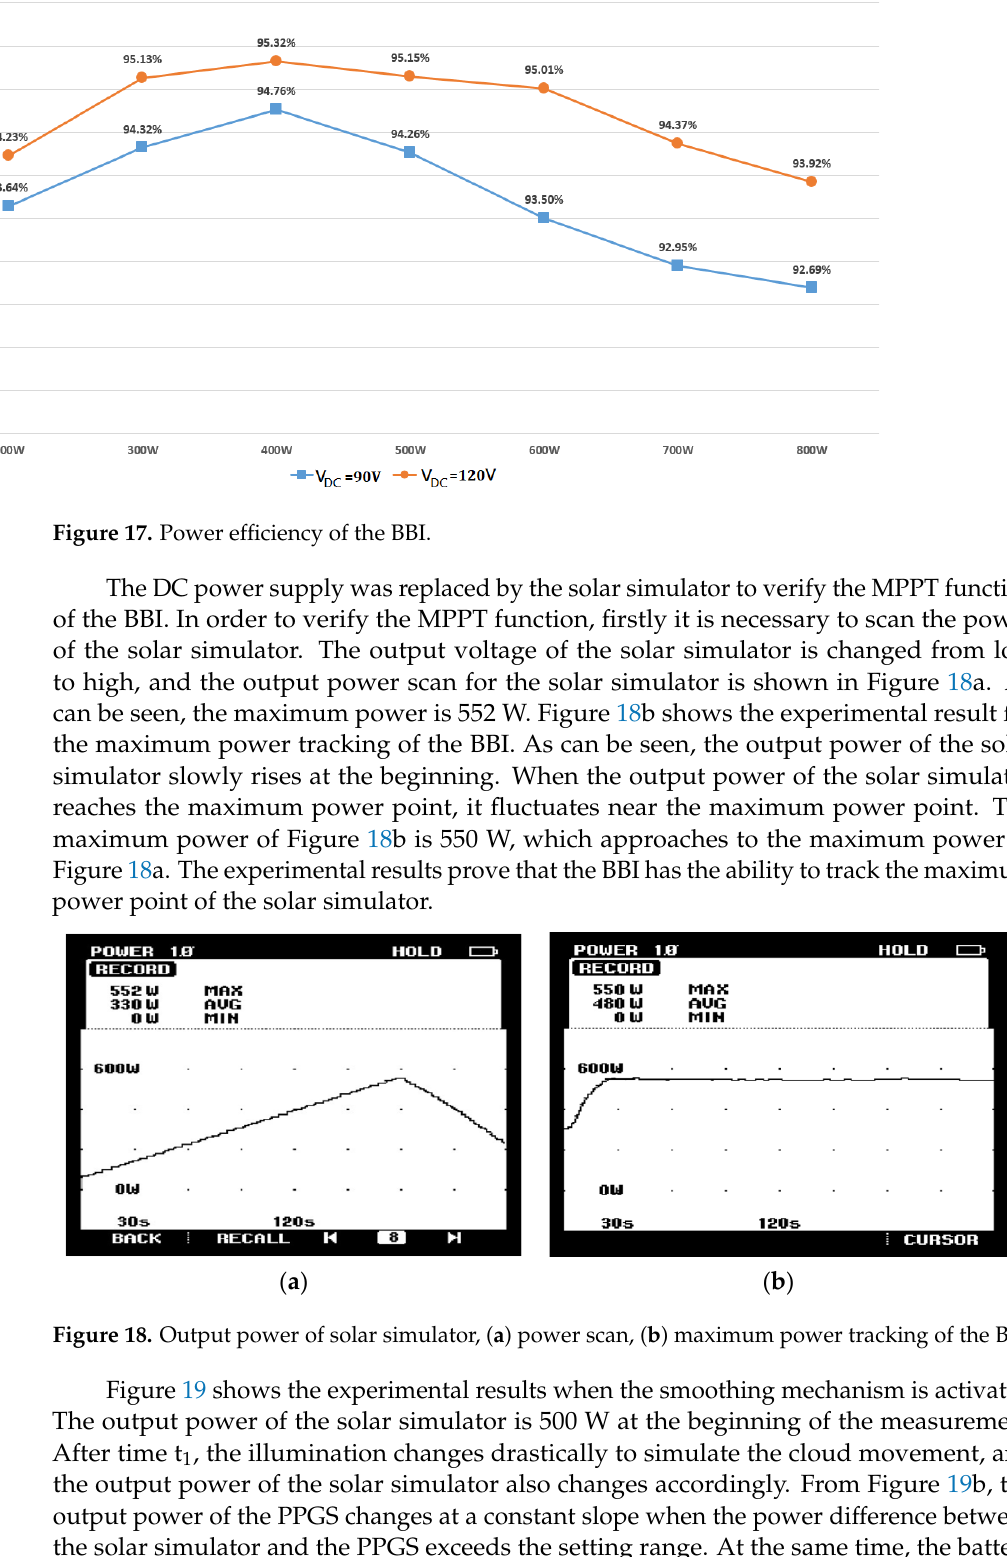
Figure 18. Output power of solar simulator, ( a ) power scan, ( b ) maximum power tracking of the